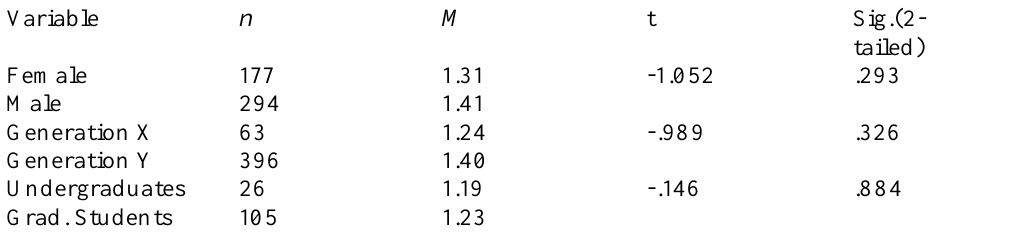
Student Satisfaction with Fully Online